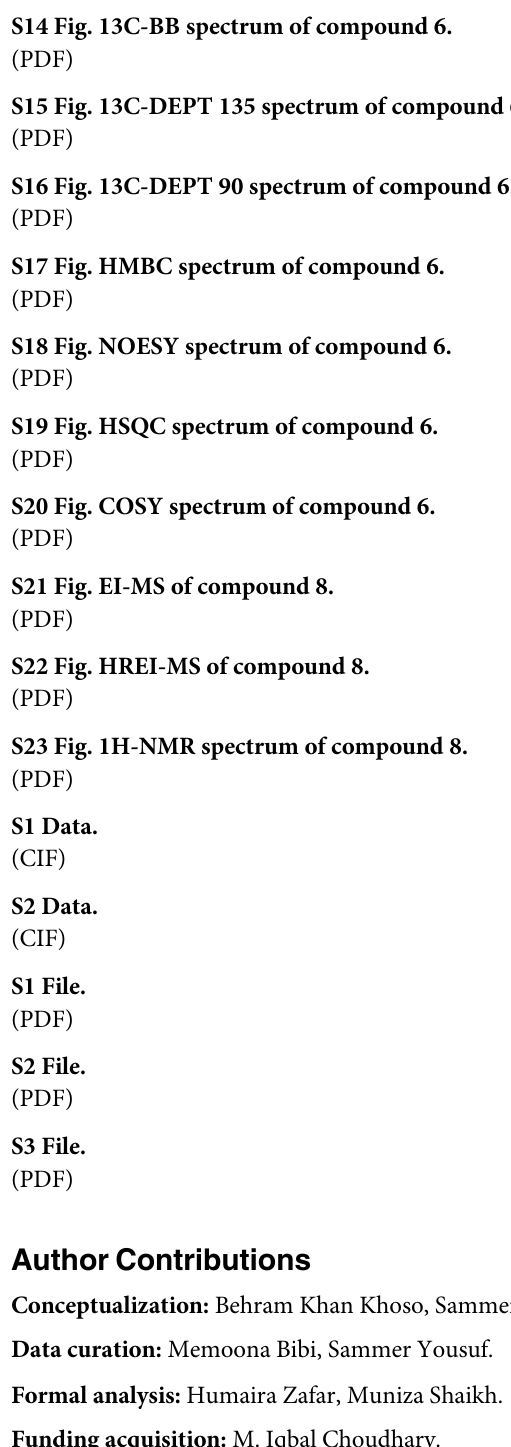
S14 Fig. 13C-BB spectrum of compound 6. (PDF) S15 Fig. 13C-DEPT 135 spectrum of compound 6. (PDF) S16 Fig. 13C-DEPT 90 spectrum of compound 6. (PDF) S17 Fig. HMBC spectrum of compound 6. (PDF) S18 Fig. NOESY spectrum of compound 6. (PDF) S19 Fig. HSQC spectrum of compound 6. (PDF) S20 Fig. COSY spectrum of compound 6. (PDF) S21 Fig. EI-MS of compound 8. (PDF) S22 Fig. HREI-MS of compound 8. (PDF) S23 Fig. 1H-NMR spectrum of compound 8. (PDF) S1 Data. S2